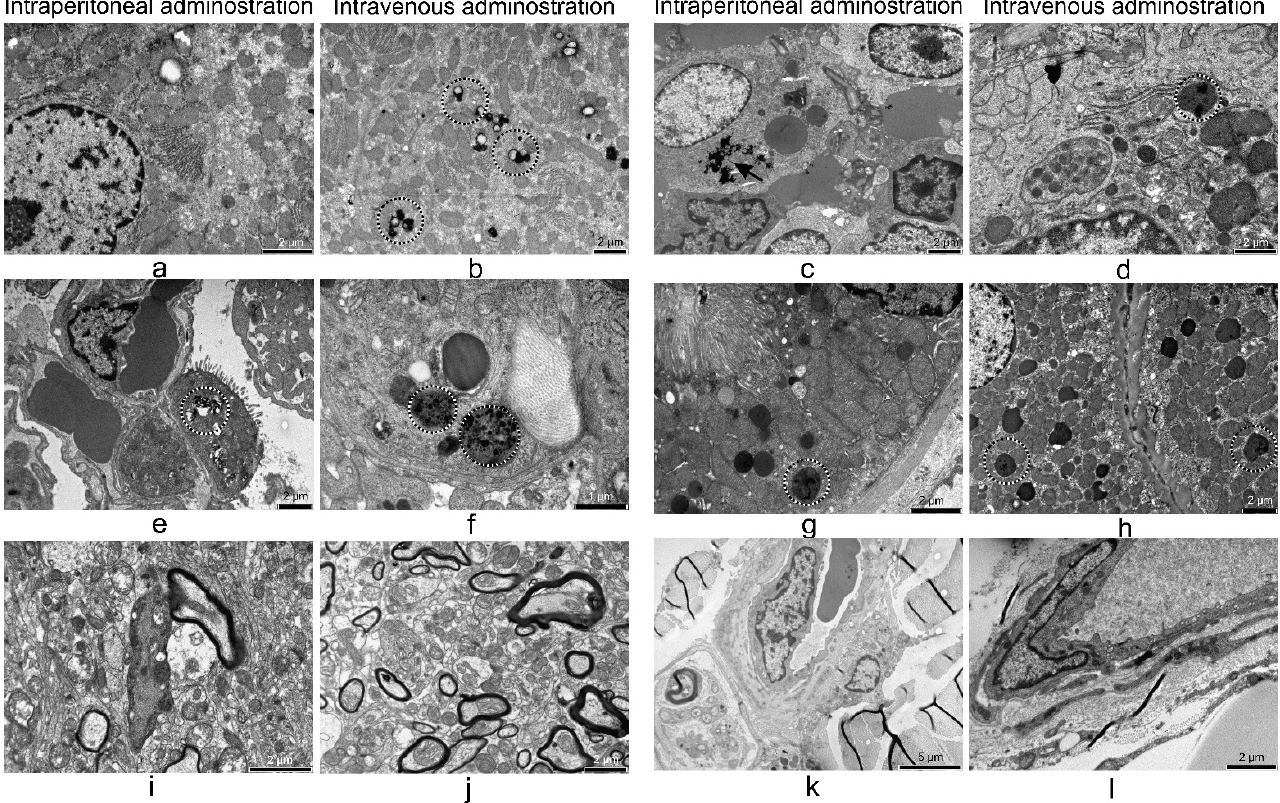
Figure 9. TEM micrographs of the organs examined 24 h after intraperitoneal or intravenous treatment with SPION-PEG clusters; liver ( a , b ) , spleen ( c , d ), lung ( e , f ), kidney ( g , h ), brain ( i , j ), and skin ( k , l ). Arrows and circles indicate the presence of electron-dense accumulations inside lysosomes or dispersed in the cytosol.